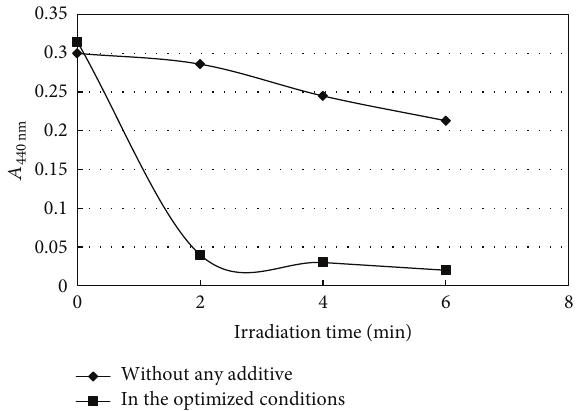
Figure 6: Changes of RNO absorbance at 440nm versus irradiation time. [ RNO ] 0 = 10 −5